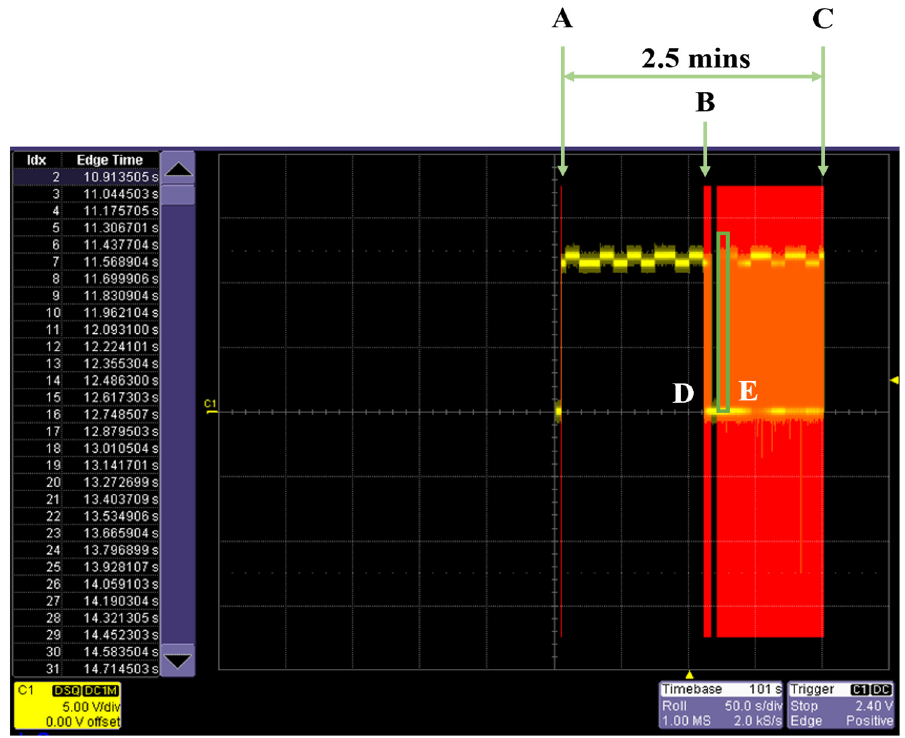
Figure 7. Oscilloscope output of the PWM waveform, A to C is the measurement runtime at 2.5 min while point B marks the start of pulse modulation and section D to E is where the PID/PWM simu ‐ lation is validated.